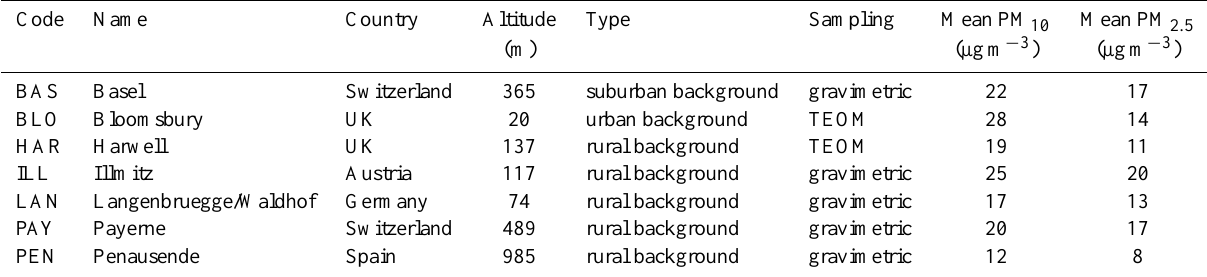
Table 1. List of considered air quality sites. PM 10 and PM 2 . 5 values are averaged over all available data.